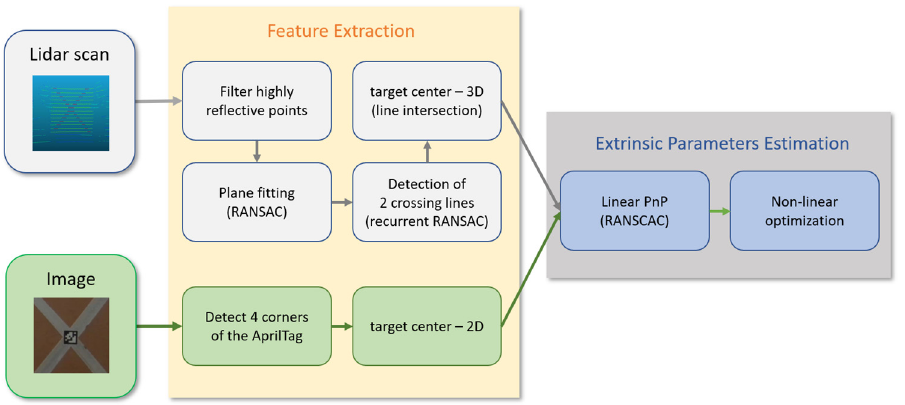
Figure 1. The outline of the geometrical calibration algorithm.